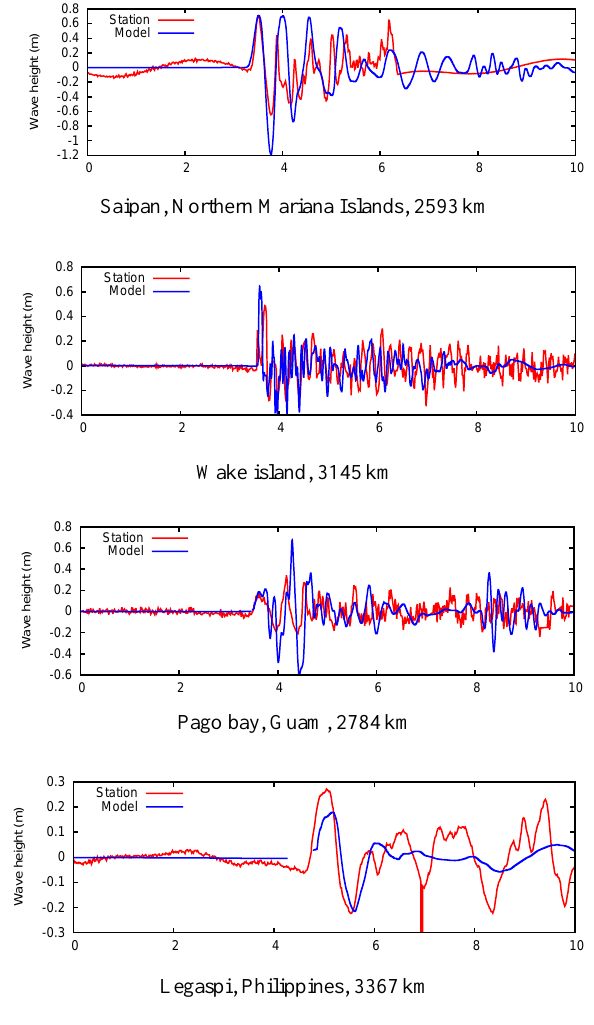
Fig. 14. Measured and modelled timeseries at GLOSS stations loca- tions (continued). Horizontal axis is time in hours. Distances from the epicentre are indicated in the